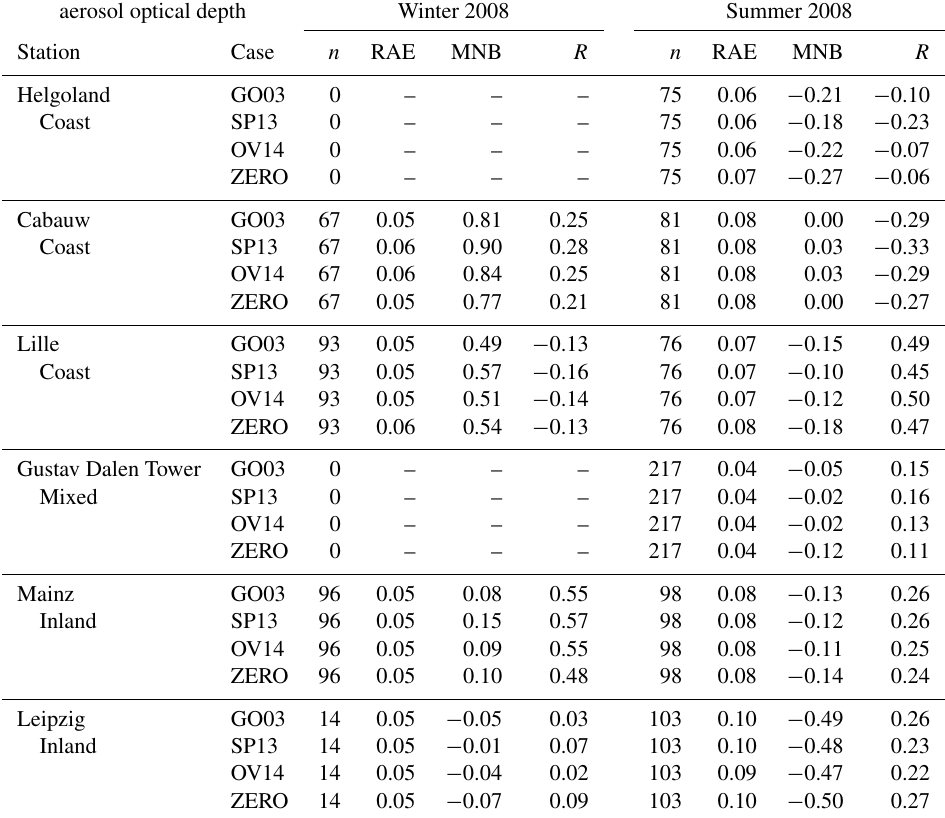
Table 6. Statistical evaluation for the comparisons between the modeled and measured aerosol optical depth (AOD) at 6 AERONET stations in the vicinity of the North and Baltic seas during winter (left) and summer 2008 (right). The data on the remaining 11 AERONET stations are shown in Table